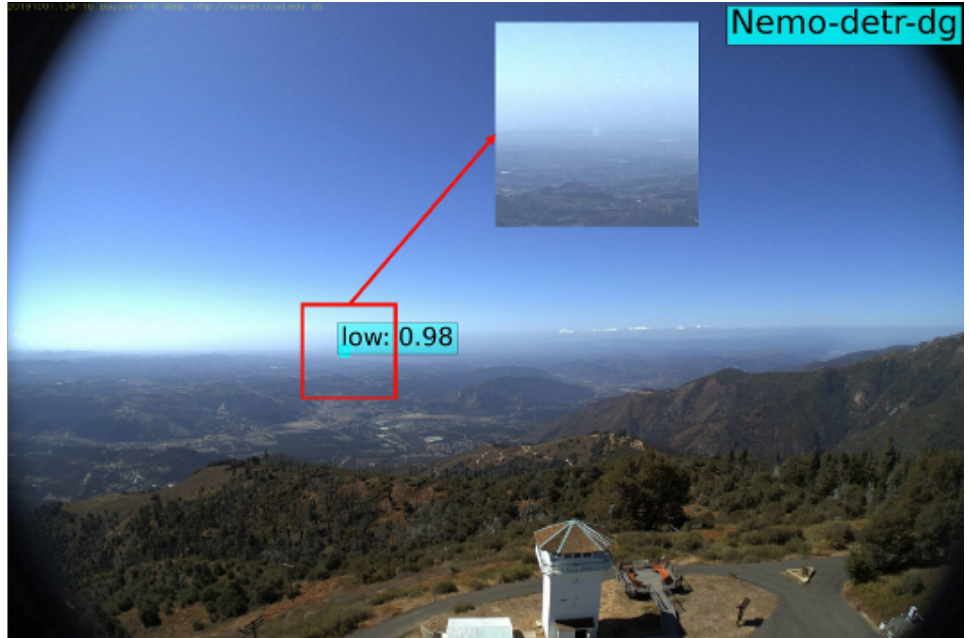
Figure 2. A tiny column of smoke near the horizon is correctly detected as low-density smoke, two minutes after the start of the fire. Viewed from a west-facing fixed camera on top of Palomar Mountain, California, on 1 October 2019. The smoke object is 24 × 26 pixels wide, and the image is 3072 × 2048 pixels, which makes the detected object less than 0.01% of the image. A focused 300 by 300 cutout of the smoke area is shown, with the smoke column